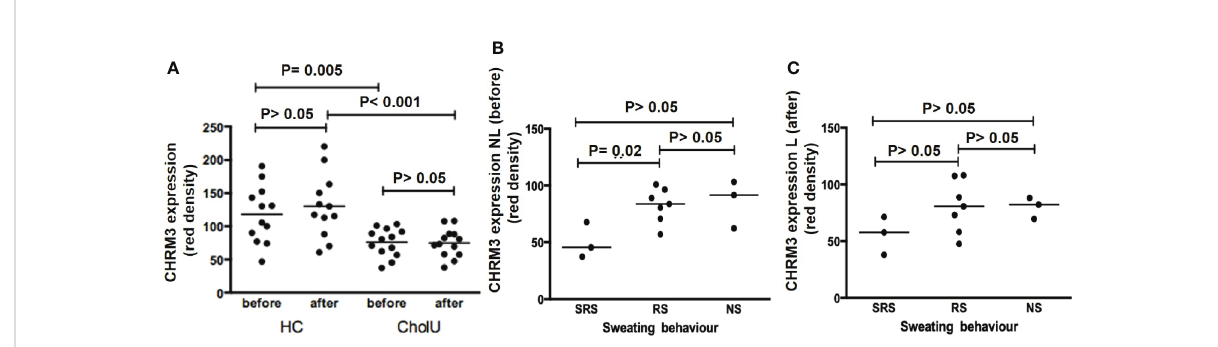
FIGURE 3 (A) CHRM3 expression on the sweat gland epithelium of HC and CholU patients ’ skin before and after pulse-controlled ergometry (PCE). (B) CHRM3 expression within CholU patients was signi fi cantly reduced before PCE provocation in the SRS patient group. (C) A similar trend was seen in the skin samples after provocation, but here no signi fi cance level was reached. NS, normal sweating CholU; RS, reduced sweating CholU; SRS, severely reduced sweating